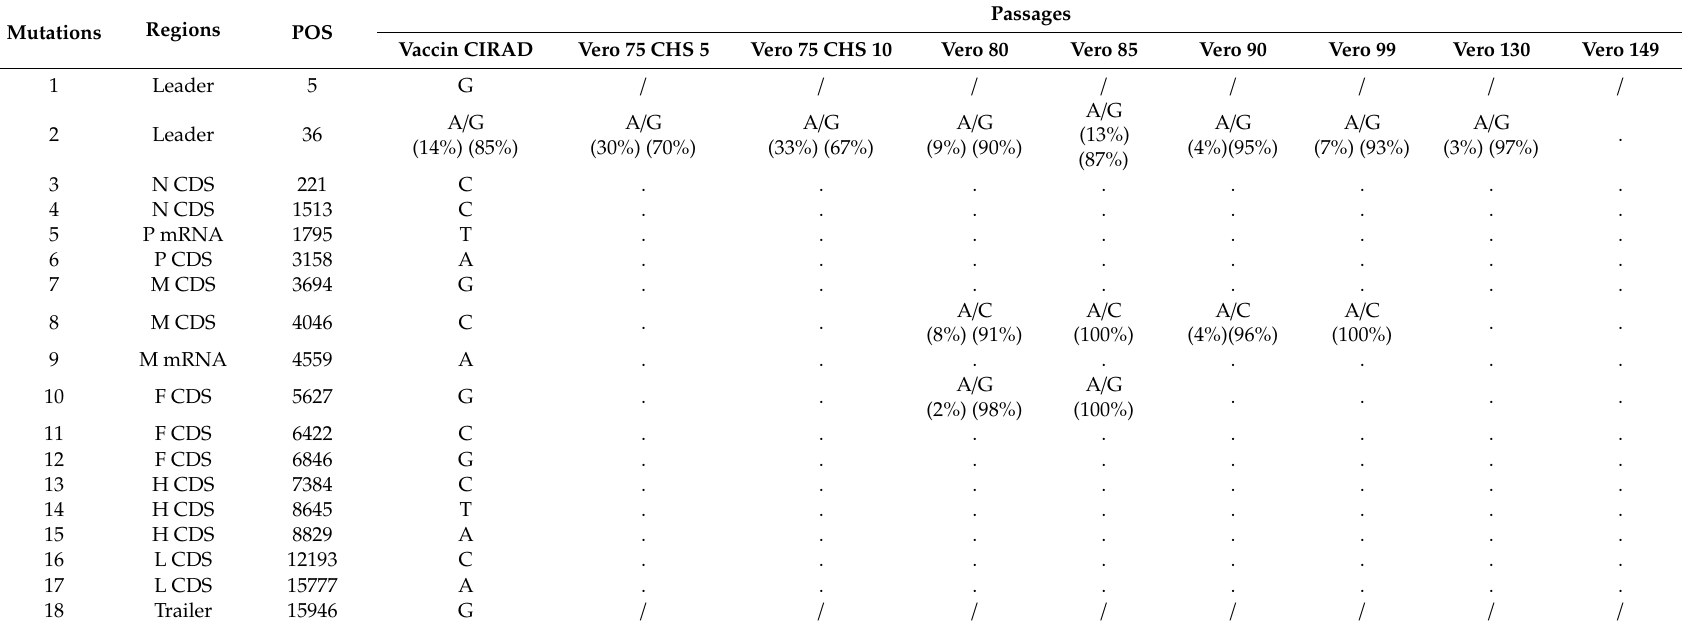
Table 2. Evolution of the mutations that led to the mitigation of the vaccine strain after the vaccine was obtained. Mutations